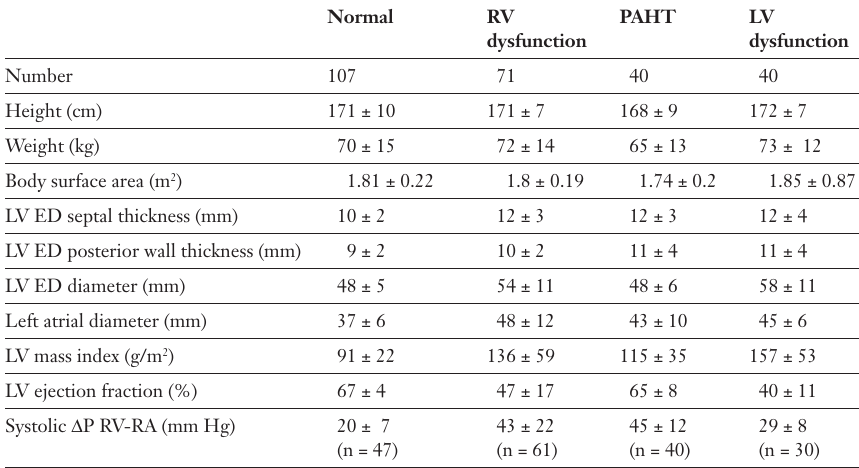
Conventional Doppler echocardio- graphic data